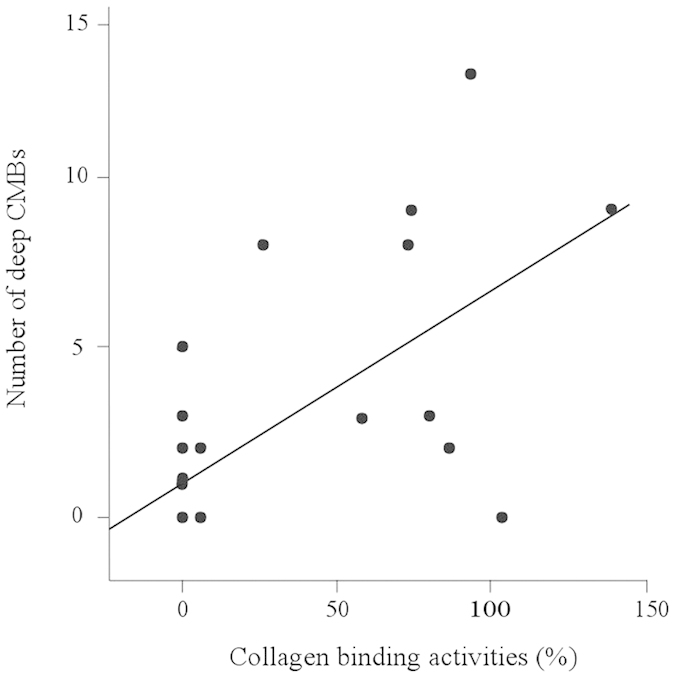
Correlation between collagen binding activity of S. mutans and number of deep CMBs.The collagen-binding activity of S. mutans significantly correlated with the number of deep CMBs (n = 50, γ = 0.054, P < 0.0001, R2 = 0.405) after one extreme outlier was excluded by using jackknife technique. S. mutans, Streptococcus mutans; CMBs, cerebral microbleeds.